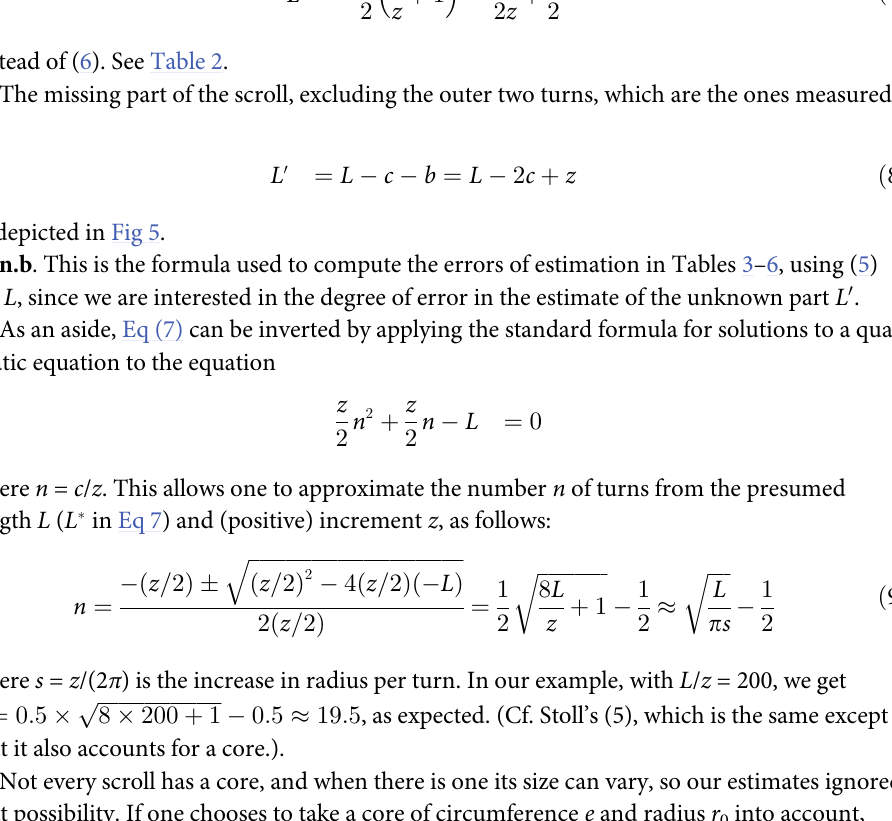
ffiffiffiffiffiffiffiffiffiffiffiffiffiffiffiffiffiffiffiffiffiffiffiffi p 8 � 200 þ 1